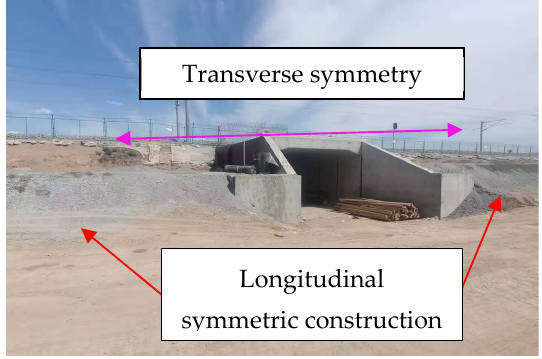
Figure 11. Symmetrical construction drawing.